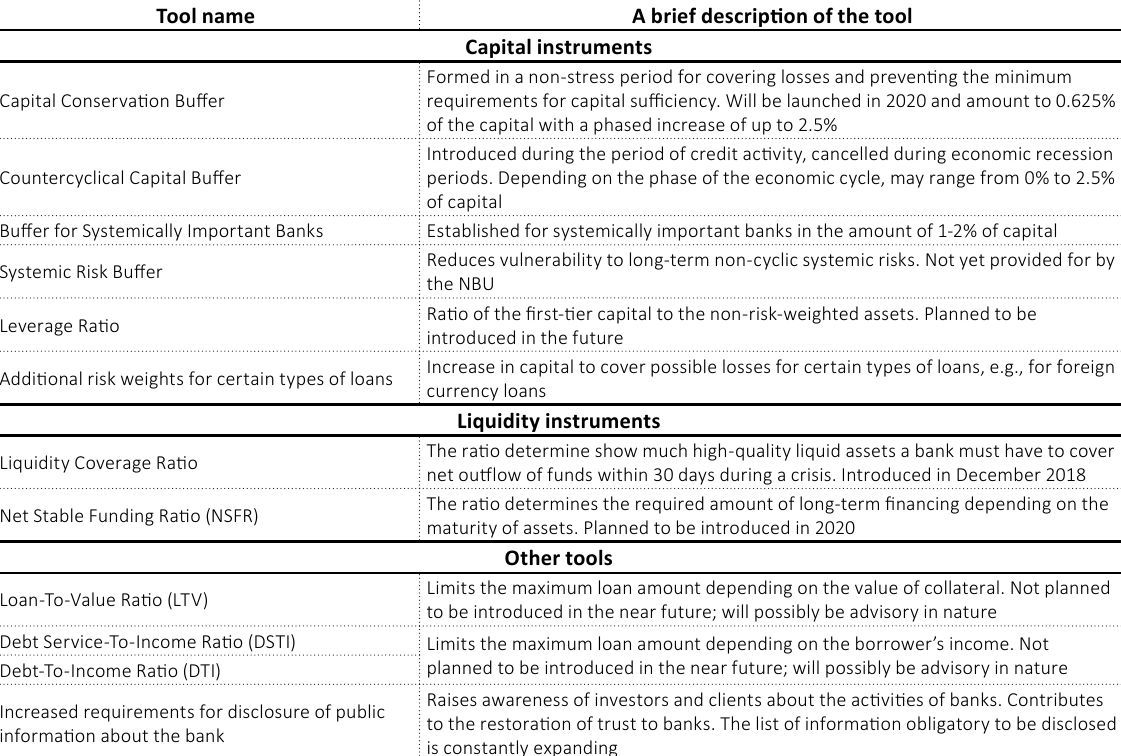
Table 1. Macroprudential tools to reduce systemic risks in the banking sector of Ukraine Source: Authors’ suggestions based on the BCBS sources